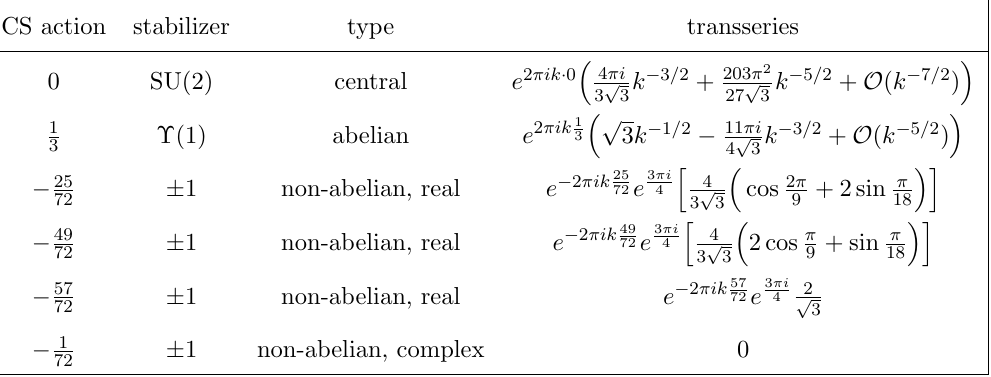
Table 4 . Transseries and classi(cid:12)cation of (cid:13)at connections on M (